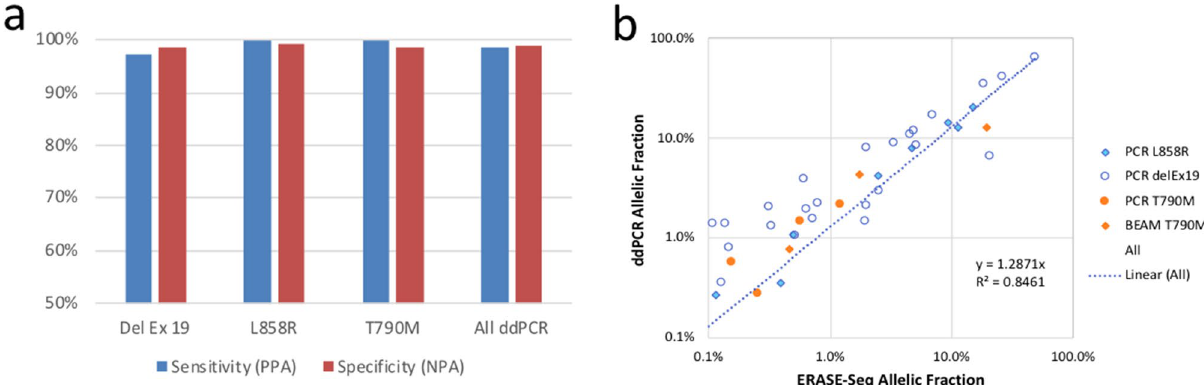
Figure 6. Sensitivity and specificity of sequencing compared to orthogonal ddPCR testing in the blood is presented for three clinically-actionable alterations: exon 19 deletions, L8585R, and T790M mutations ( a ). In addition to each individual biomarker, comprehensive ddPCR sensitivity/specificity for all targets is plotted. A scatter plot compares allele frequencies reported by ddPCR versus ERASE-Seq sequencing results ( b ).